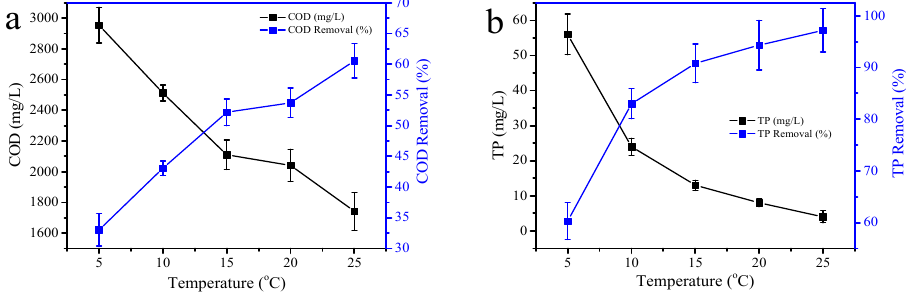
Figure 4. Effect of temperatures on CEPT efficiencies: ( a ) COD removal and ( b ) TP removal (FeCl 3 40 mg/L, APAM 0.2 mg/L).